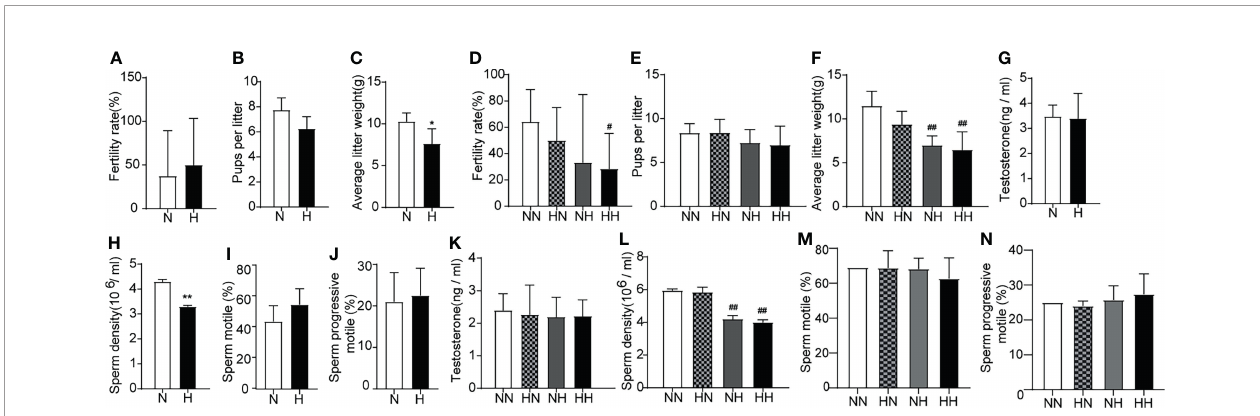
FIGURE 3 | Reproduction function parameters and acrosome reaction and integrity induced by high-fat diet during sexual development Fertility (A) , pups per litter (B) and average litter weight (C) were observed, testosterone levels (G) (n=8 for each group), sperm parameters (H – J) (n=4 for each group) were assayed at the 8th week of feeding. Fertility (D) , pups per litter (E) and average litter weight (F) were observed, testosterone levels (K) and sperm parameters (L – N) were assayed at the 16th week of feeding (n=8 for each group). *p < 0.05, **p <0.01 vs the N group. #p < 0.05, ##p < 0.01 vs the NN.